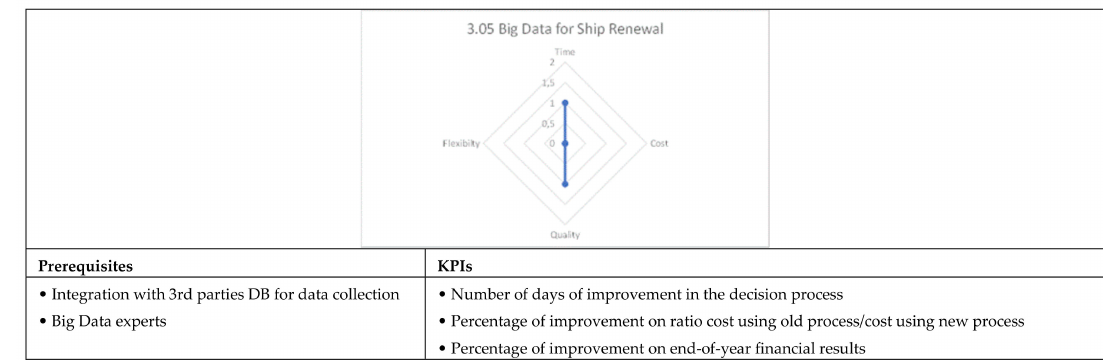
Figure A31. Big data for ship renewal data sheet.